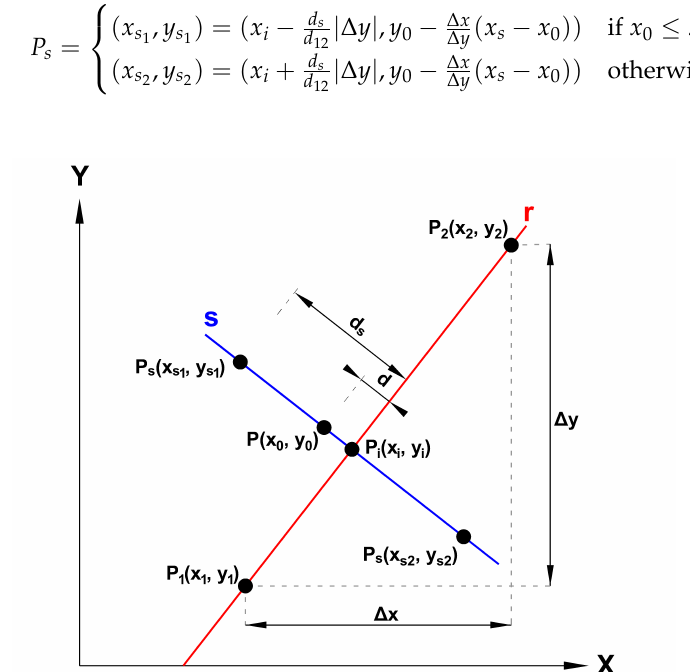
Figure 9. Safe location